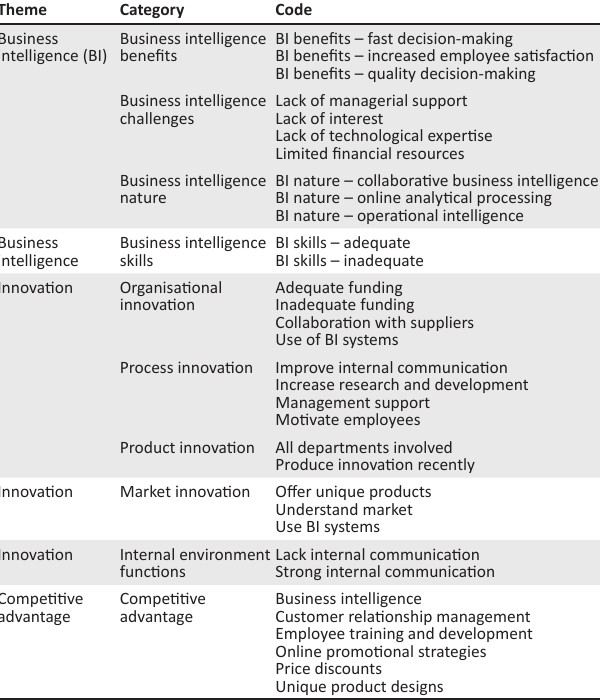
TABLE 1: Layout of the themes, categories and